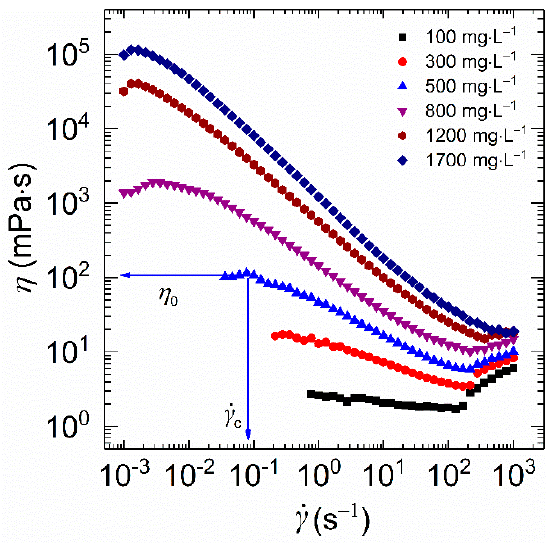
Figure 5. Shear viscosity plotted as a function of shear rate for HVFR solutions with different concentrations at 30 ° C.